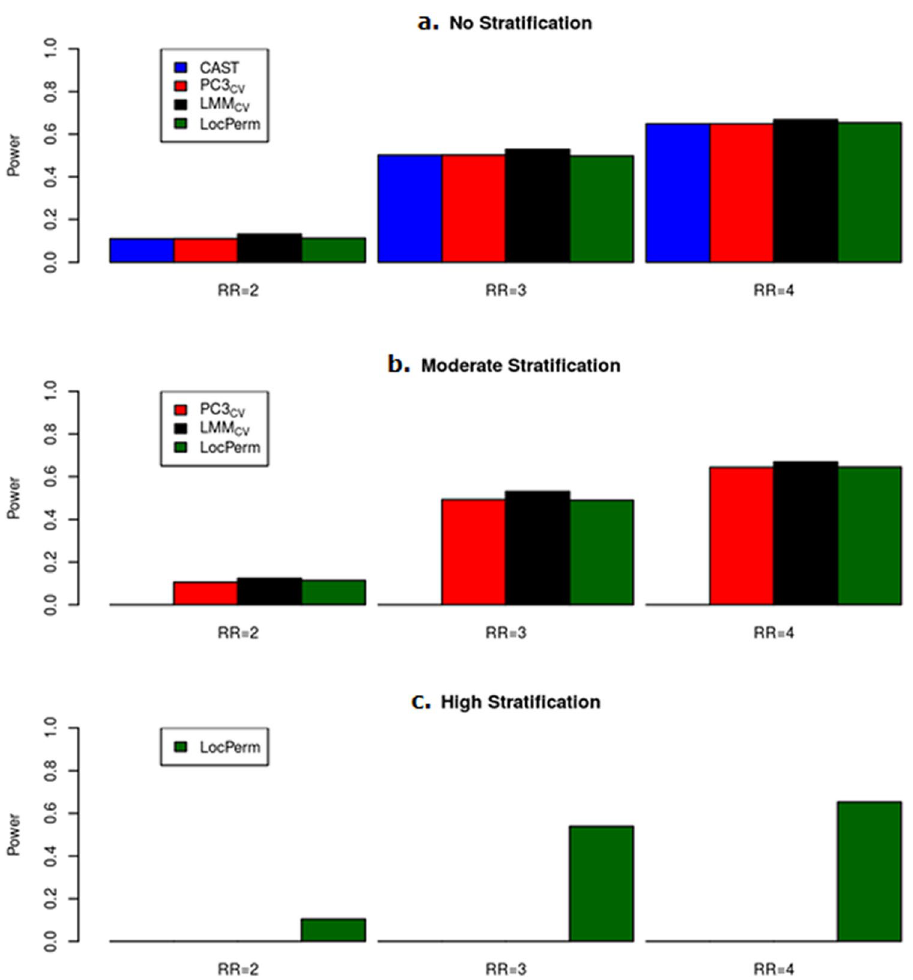
Figure 3. Histogram of powers for methods with a correct type I error rate for the large size European sample (n = 1523) at the level α = 0.001 . ( a ) Without stratification. ( b ) With moderate stratification. ( c ) With high stratification. Relative risks considered vary from 2 to 4 on the